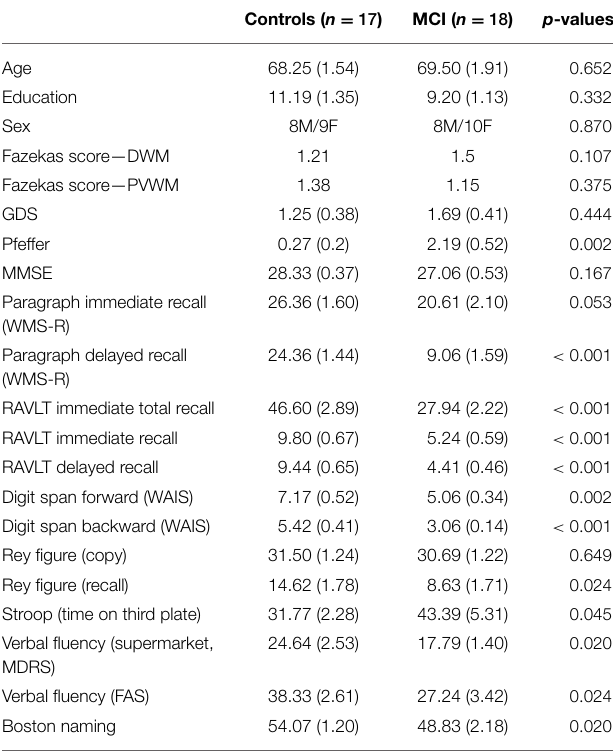
TABLE 1 | Characteristics of the subjects with MCI and